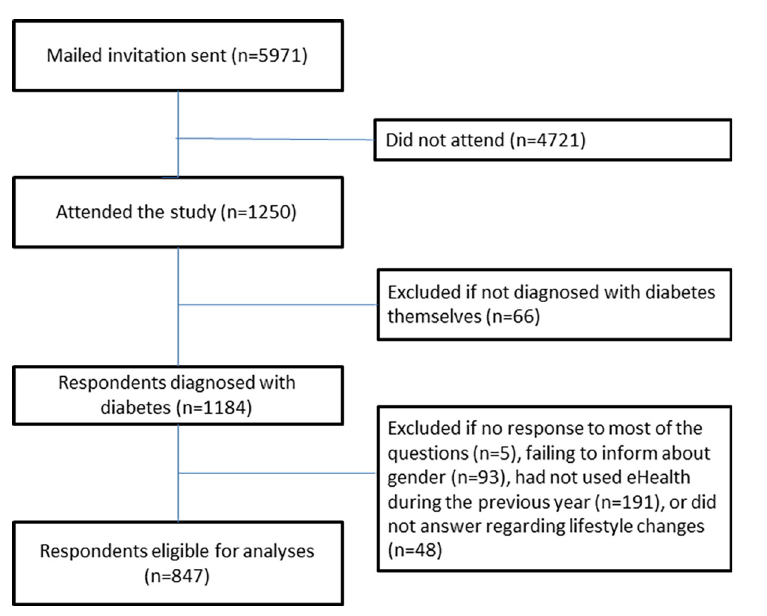
Fig 1. Flow chart of study